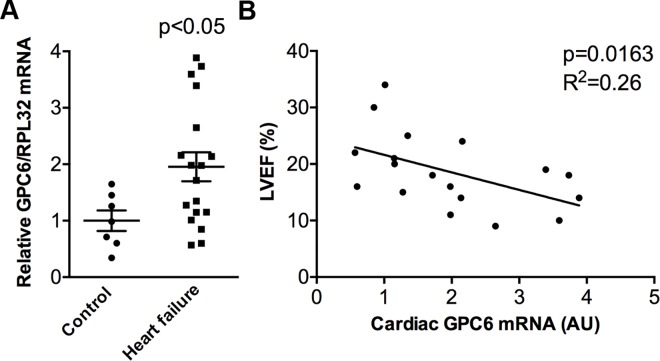
Glypican-6 expression is upregulated in the failing human heart.Relative GPC6 mRNA levels in left ventricular biopsies from end-stage heart failure patients (n = 18) compared to controls (n = 7) (A). See Table 2 for patient characteristics. GPC6 mRNA levels were normalized to ribosomal protein L32 (RPL32) expression and data presented as individual data points. Unpaired Student’s t-test was used to test for statistical significance. Pearson correlation between left ventricular GPC6 mRNA level and ejection fraction (EF) in end-stage heart failure patients (n = 18) (B).